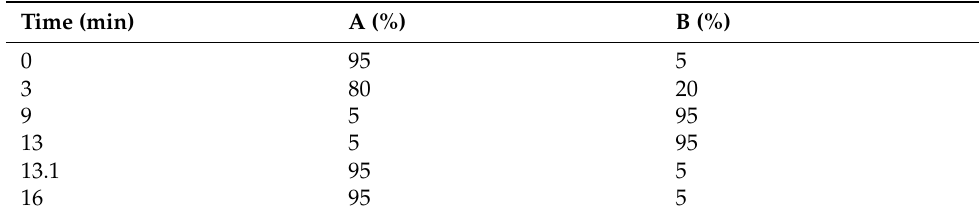
Table 3. Time variation of the solvent